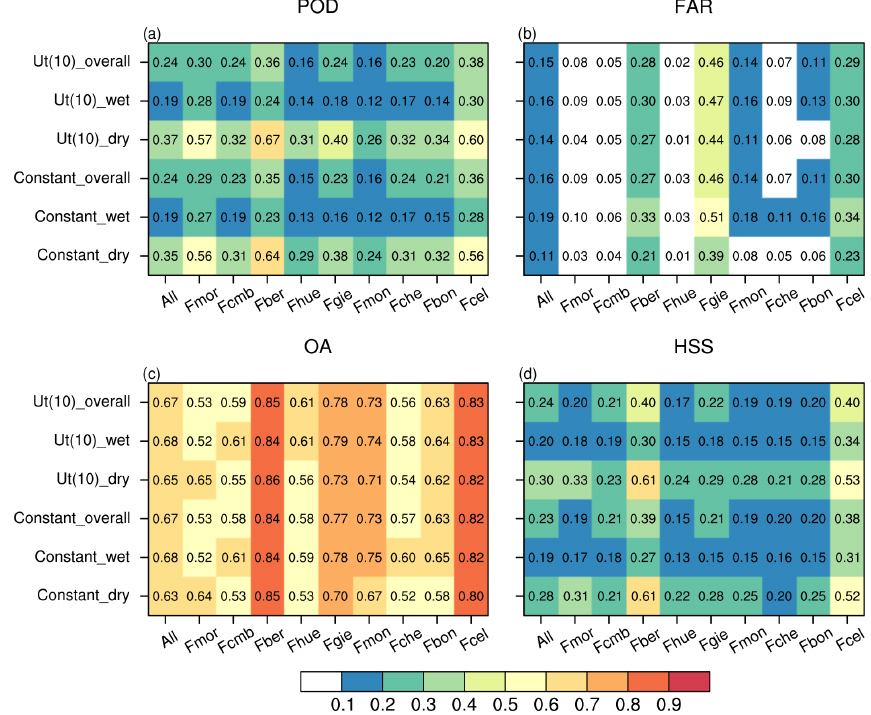
Figure 12. The POD (a) , FAR (b) , OA (c) and HSS (d) of indirect methods using constant threshold wind speed (7.7ms − 1 for dry snow transport and 9.9ms − 1 for wet snow transport, abbreviated as Constant_dry and Constant_wet, respectively), and dynamic threshold adapts to the evolution of air temperature (abbreviating as Ut(10), Ut(10)_wet and Ut(10)_dry shares the same expression but used to detect wet snow and dry snow transport, respectively). Constant_overall and Ut(10)_overall are the synthetical metrics of wet snow and dry snow